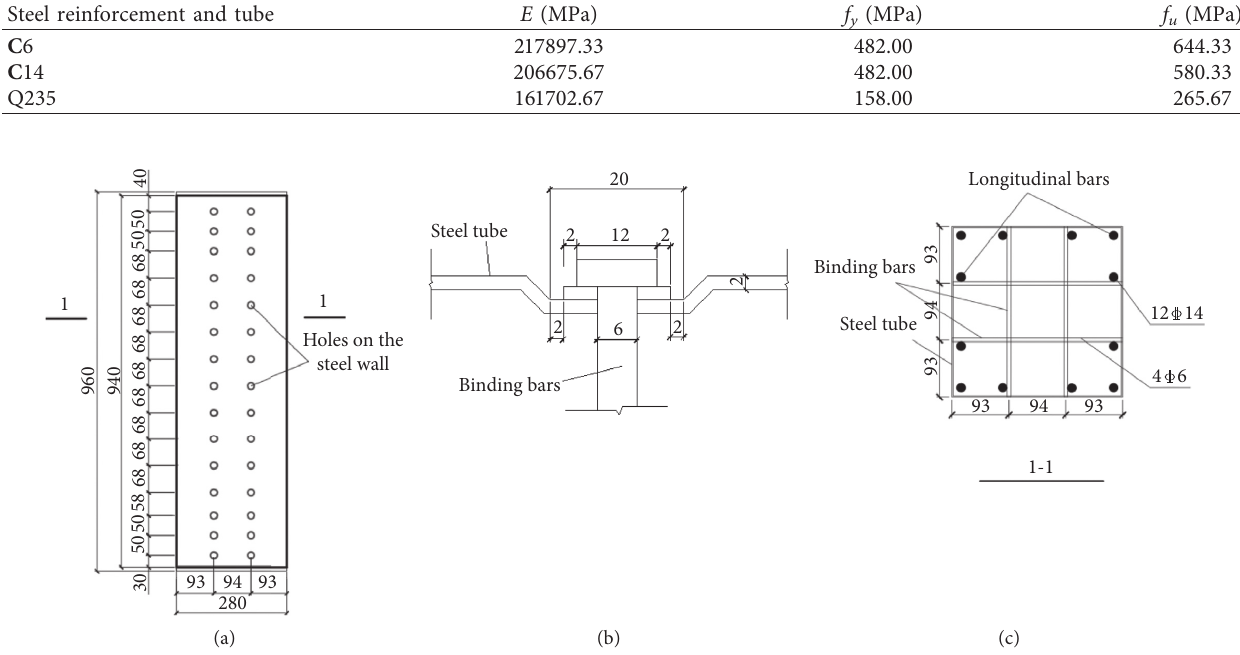
Figure 1: Dimension and detailing of specimens (unit: mm): (a) elevation drawing, (b) detail of binding bar construction, and (c) section of reinforcing bars.